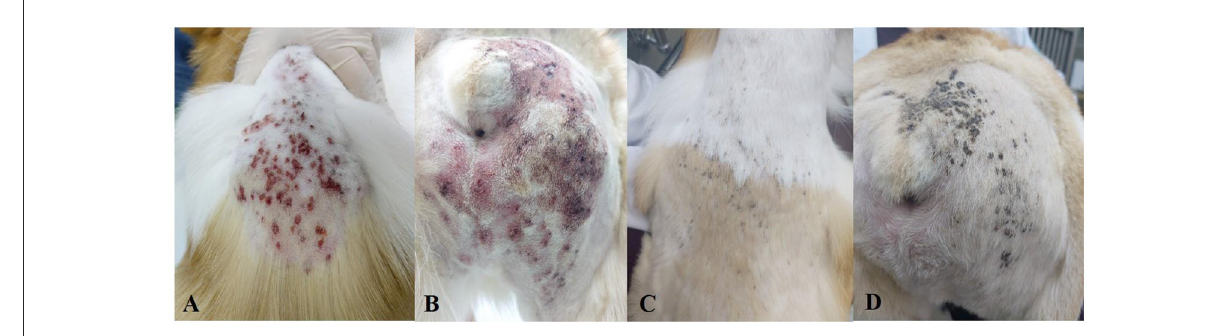
FIGURE2 Photographs of the skin condition of Case 2. (A,B) Systemic ulcerative patchy lesions at presentation. (C,D) 10 days later, after treatment initiation, the lesions were mostly improved.